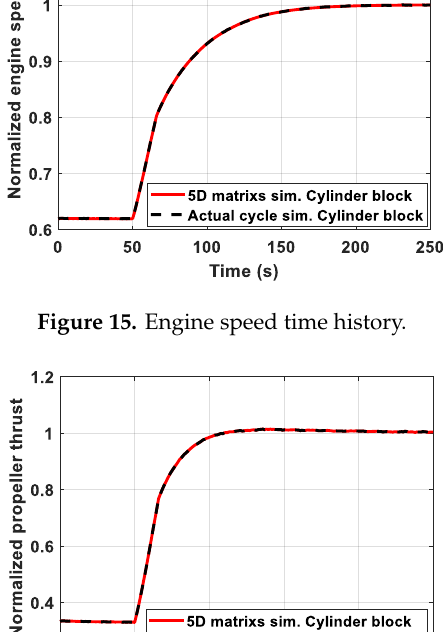
Figure 16. Propeller thrust time history.